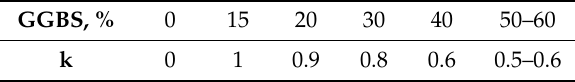
Figure 10. Curves of GGBS concrete deformation fitted to the reference curve (series A, CEM I). Table 3. Experimentally determined